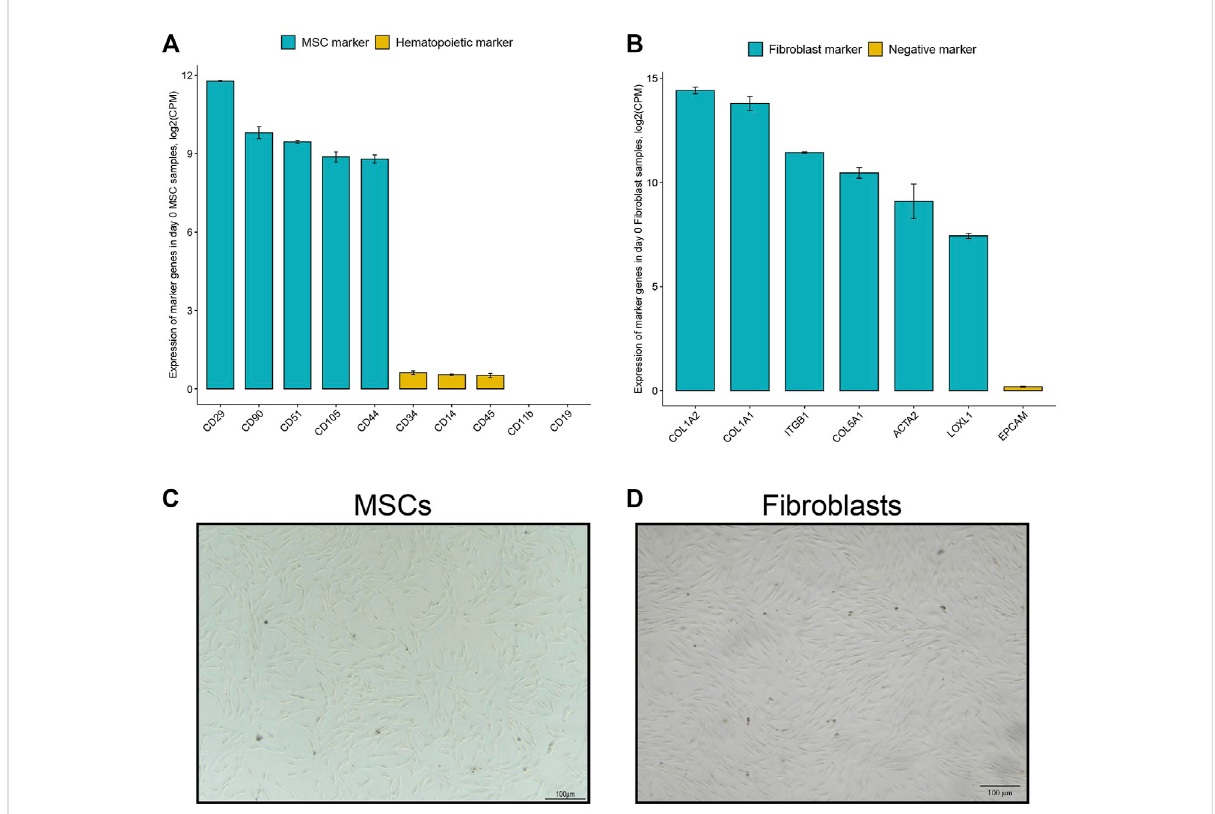
FIGURE 1 Characterization of MSCs and dermal fi broblasts. (A) Marker gene expression in undifferentiated MSCs. Data show expression of known mesenchymalstemcellsmarkersandlackoforlowexpressionofhematopoieticmarkers.Dataaremean+SE(standarderror), n =3. (B) Markergene expression in undifferentiated dermal fi broblasts. Data show expression of known fi broblast markers such as collagen genes, ITGB1, ACTA2 and LOXL1, and low expression of fi broblast negative marker EpCAM. Data are mean +SE, n = 4. (C) Cell morphology images of undifferentiated MSCs and (D) undifferentiated fi broblasts before initiated osteoblastic differentiation treatment. Light microscope, scale bar: 100